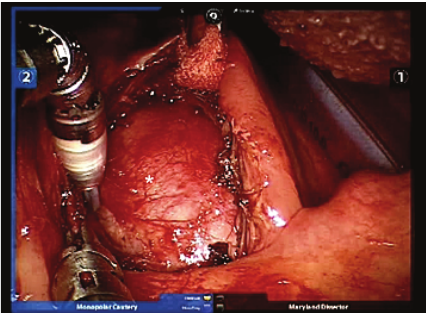
Figure 4: Retrostyloid schwannoma covered by surrounding fascia (white